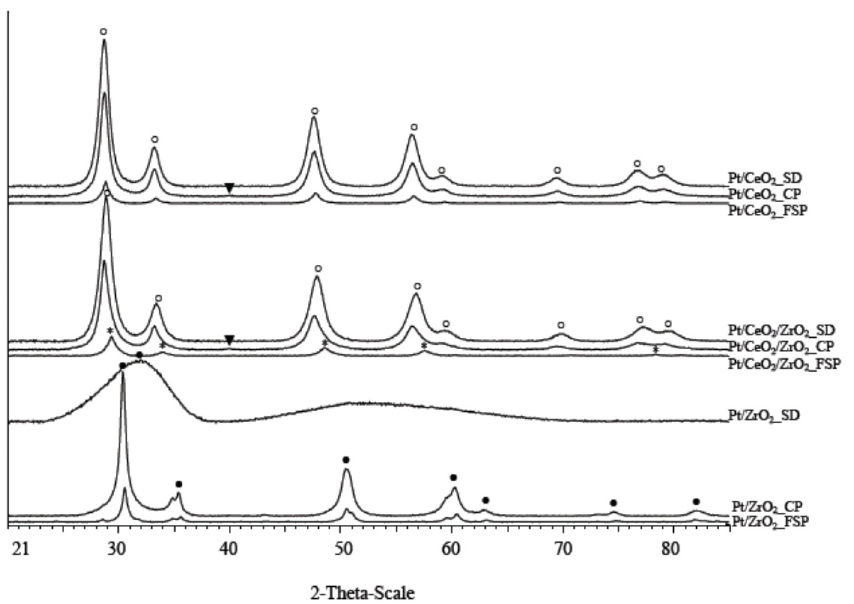
Figure 1. XRD patterns of the catalysts prepared by coprecipitation/impregnation (CP), spray drying (SD), and flame spray pyrolysis (FSP): ( ○ ) CeO 2 , ( ● ) ZrO 2 , (*) Ce x Zr 1-x O 2 , ( ▼ ) PtO 2 .